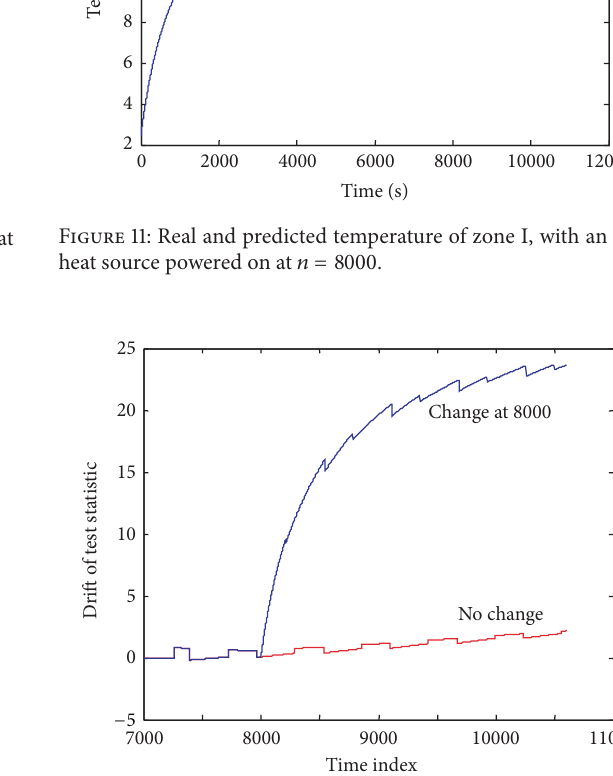
Figure 12: Drift of the test statistic for scenario II, under no change and an extra heat source powered on at 𝑛 = 8000